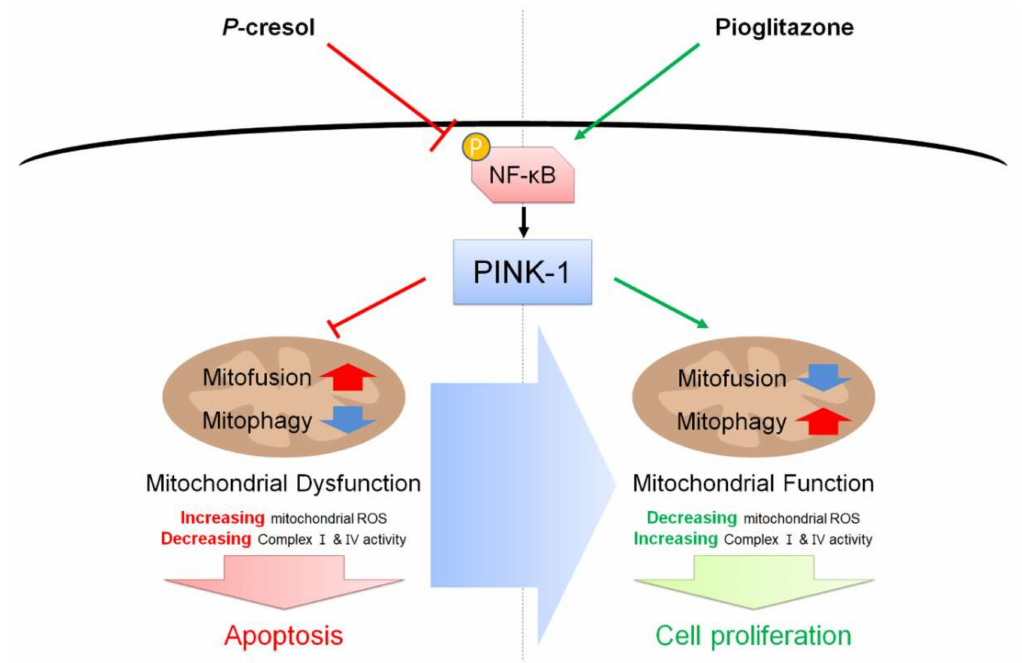
Figure 7. Schematic representation of possible mechanisms by which pioglitazone prevents PC-induced dysfunction of mitochondria in MSCs through the NF- κ B–PINK-1 signal pathway. Under the PC exposure condition, the activation of NF- κ B and the expression of PINK-1 are decreased, resulting in apoptosis induced by dysfunction of mitochondria. Treatment with pioglitazone activates NF- κ B and increases the expression of PINK-1 under the PC exposure condition, leading to the reinstatement of function of mitochondria and the augmentation of MSC proliferation. Red thick arrow means up-regulation, and blue thick arrow means